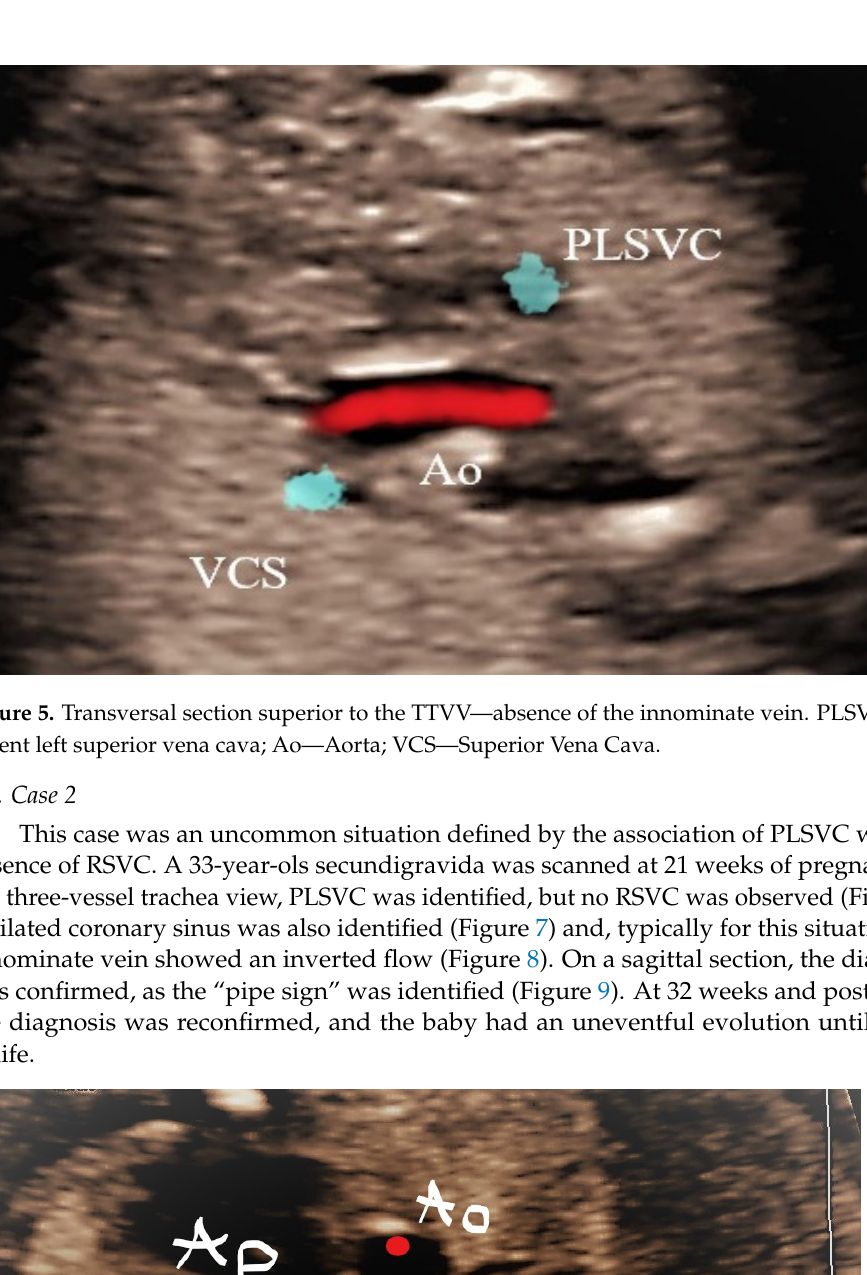
Figure 3. Sagittal section depicting the pipeline aspect of the persistent left superior vena cava (PLSVC).